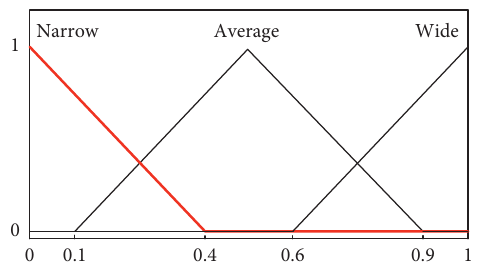
Figure 27: FV membership functions for LV “control range”.